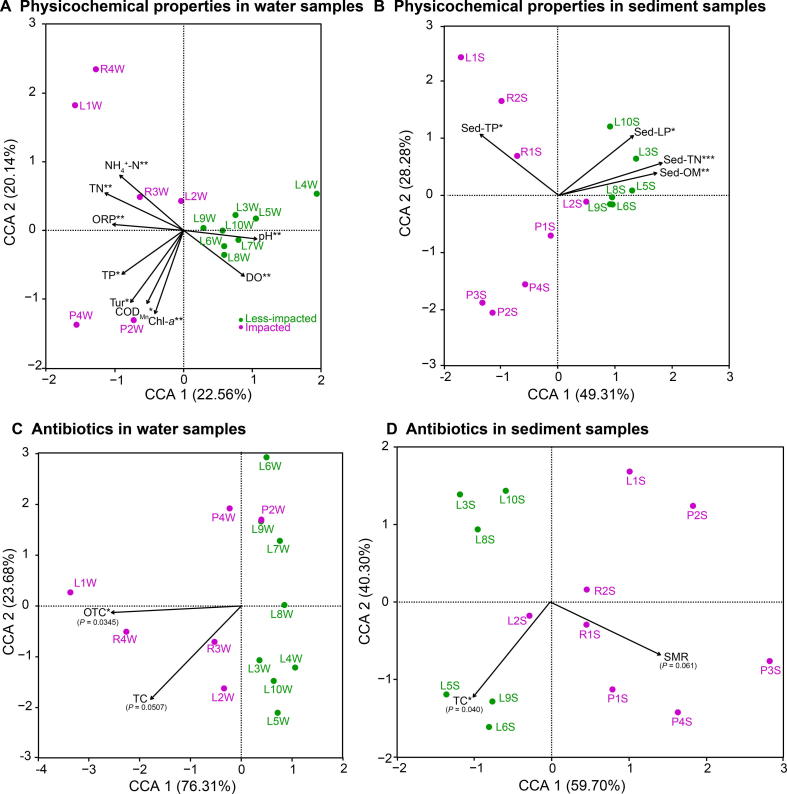
Canonical correspondence analysis plots of physicochemical properties and antibiotic data driving water and sediment microbial community structurePhysicochemical properties of water samples (A) and sediment samples (B), as well as antibiotic data for water samples (C) and sediment samples (D) from Honghu Lake. We utilized the ‘envfit’ function with 999 permutations to reveal significant correlations between physicochemical properties, antibiotics, and microbial communities. *P < 0.05; **P < 0.01; ***P < 0.001. DO, dissolved oxygen; ORP, oxidation–reduction potential; Tur, turbidity; Chl-a, chlorophyll-a; TP, total phosphorus; TN, total nitrogen; CODMn, oxygen consumption; OM, organic matter; LP, labile phosphorus; OTC, oxytetracycline; TC, tetracycline; SMR, sulfamerazine.